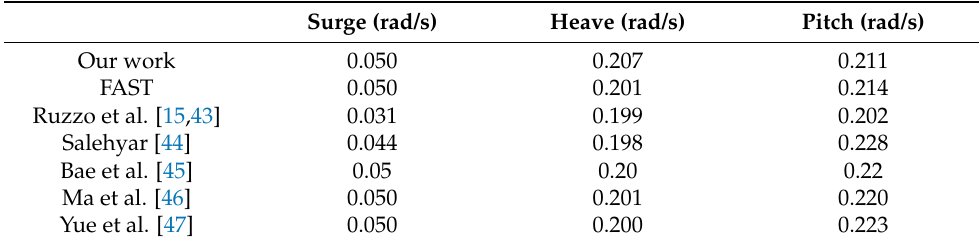
Table 4. Natural frequencies of SPAR-type